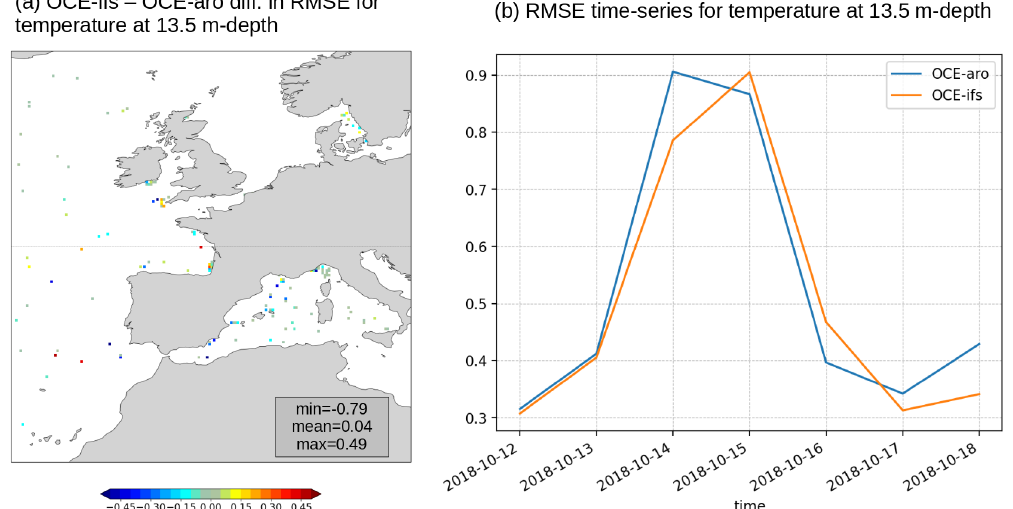
Figure 8. Forecast error for temperature at vertical level 10 (around 13.5m depth), expressed as a RMSE in degrees Celsius: (a) difference between OCE-ifs errors and OCE-aro errors at observation points, during the 7 simulated days (blue dot means lower RMSE in OCE-ifs); (b) time series of the daily error, averaged over all observations available for each day, for OCE-ifs and OCE-aro.